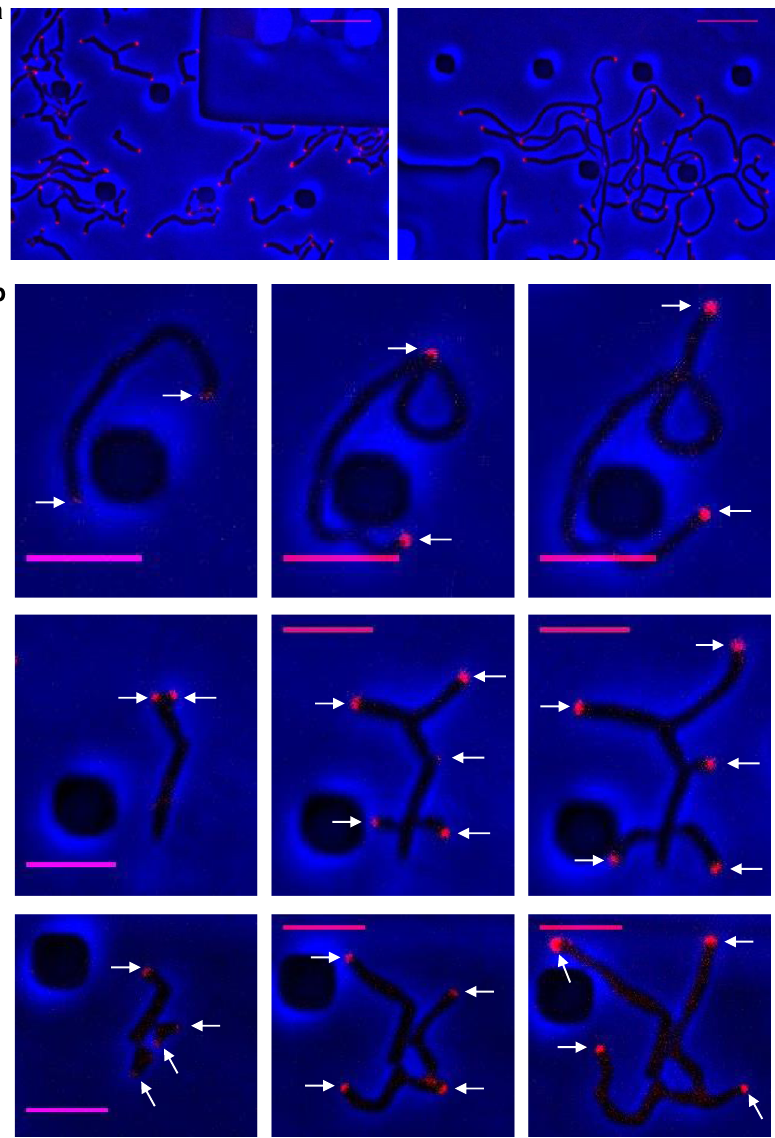
Fig. 4 Cell regrowth following fragmentation. a DivIVA tip localisation in wild type (left panel) and Δ ftsZ mutant (right panel). b Representative examples of the types of cell regrowth of fragments in the Δ ftsZ mutant from both ends (top), multiple/new sites (middle) and from an existing pole and/or bulge (bottom). All spores and fragments were grown in the CellASIC ONIX micro fl uidic chamber with TSB medium, using a 500 ms exposure for acquiring the mCherry signal. White arrows indicate the sites of DivIVA-mCherry localisation. Scale bars = 10 µ m in a and 5 µ m in